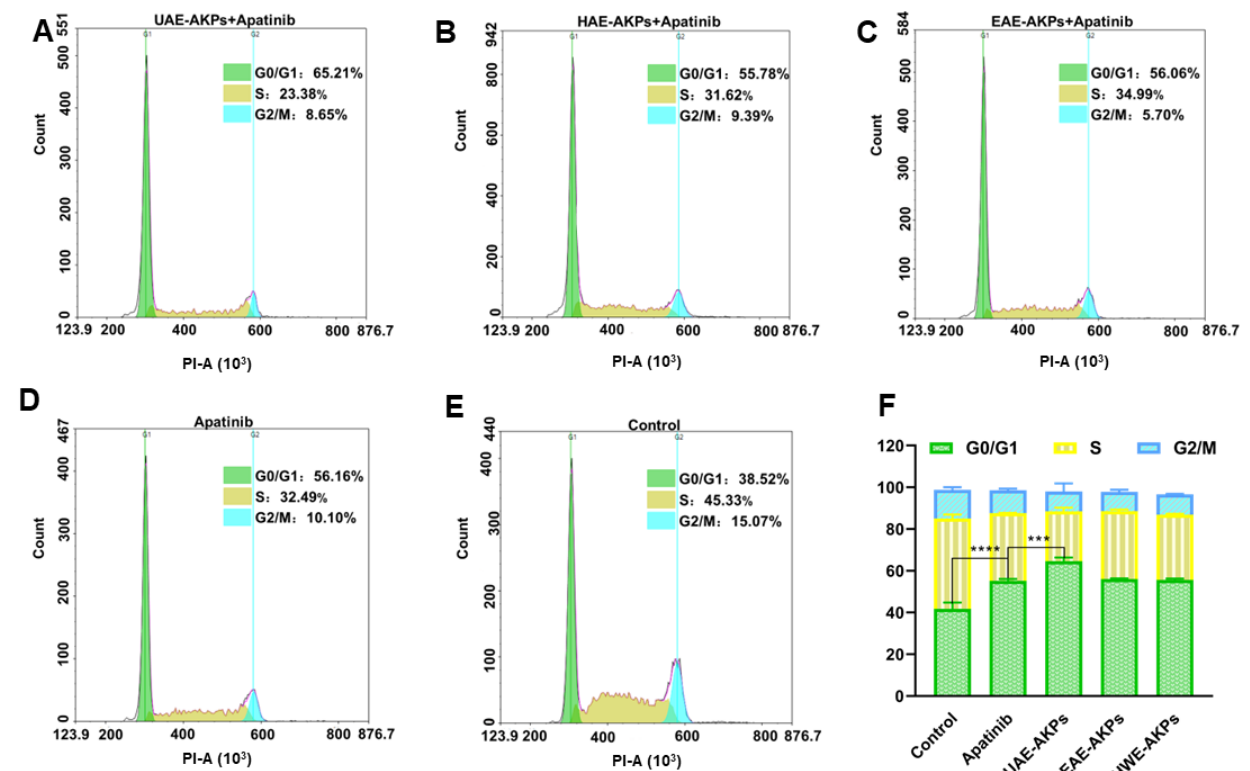
Figure 5. Effects of single or combined treatments on the cell cycle of SGC-7901 cells (( A ) UAE-AKPs+ apatinib group; ( B ) HWE-AKPs+ apatinib group; ( C ) EAE-AKPs+ apatinib group; ( D ) apatinib group; ( E ) control group; ( F ) cell cycle). Data are representative as mean ± SEM. *** p <0.001, **** p <0.0001.